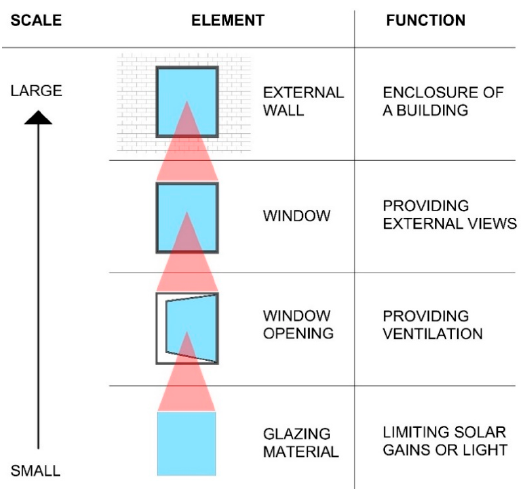
Figure 5. Hierarchical components on a conventional façade system at diverse scales including external walls, windows, window openings, and glazing